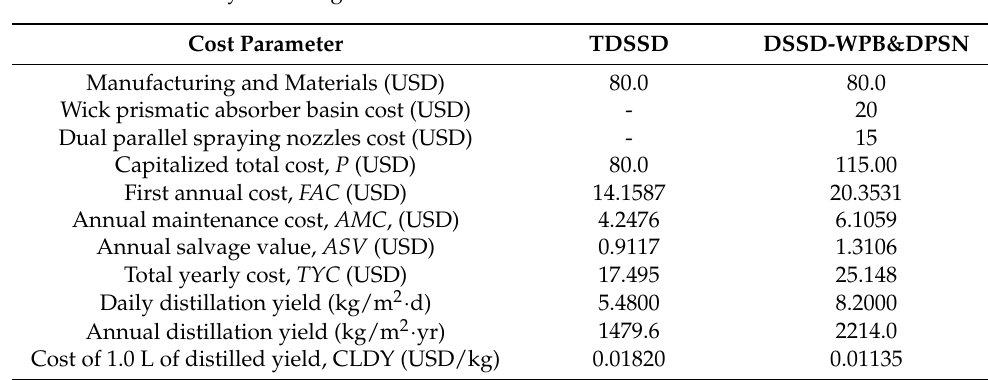
Table 3. Life cost analysis